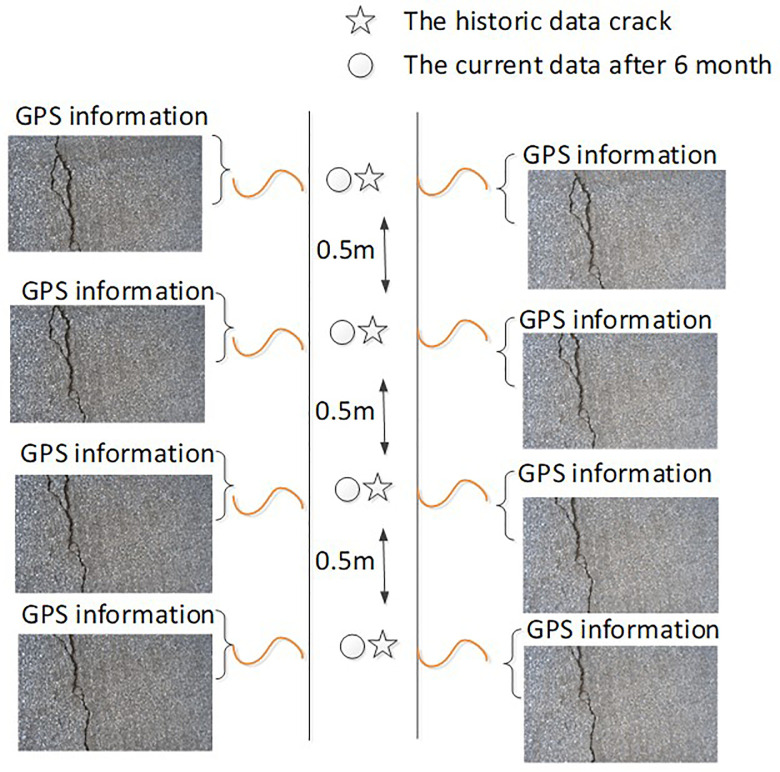
The organization form of query data and historical data.